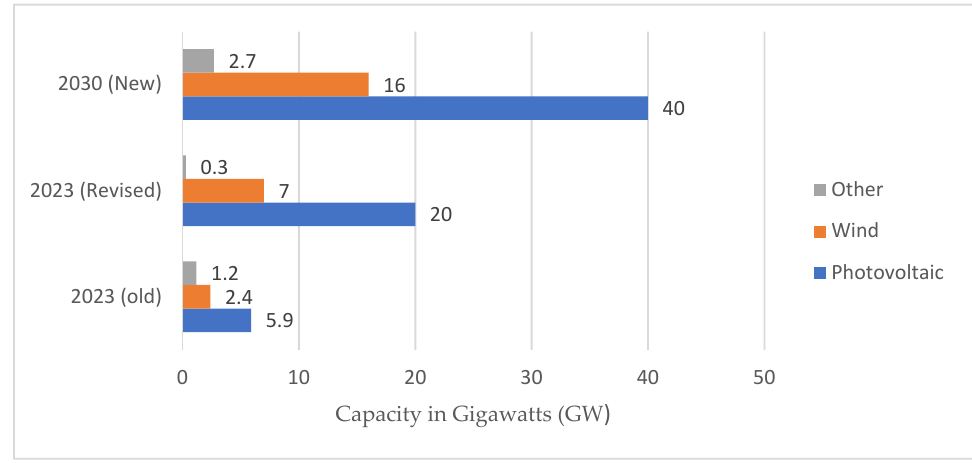
Figure 3. Revised renewable targets of KSA’s Vision 2030.